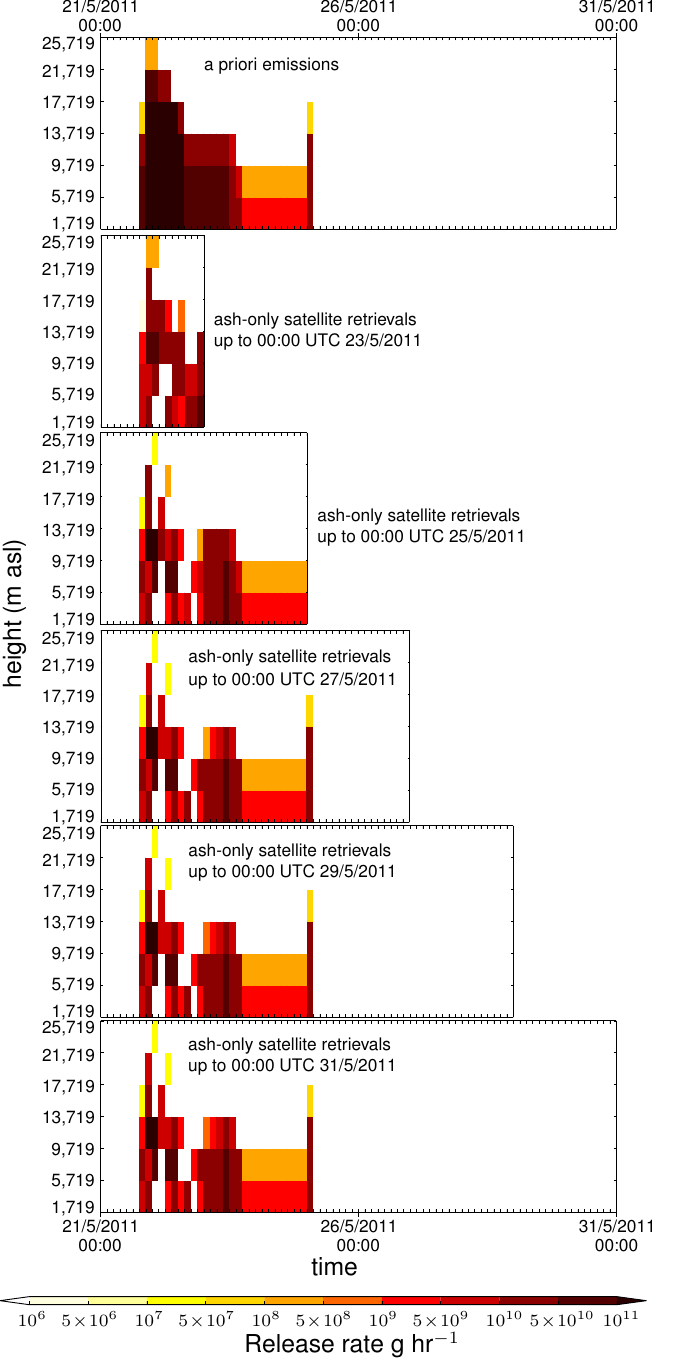
Figure 8. Emission profiles (g hr − 1 ) estimated by InTEM for the 2011 Grímsvötn eruption. The a priori emissions and the inversion emission profiles using the ash-only satellite retrievals available up to various cut-off times are shown. Each inversion emission profile uses two more days of satellite retrievals than the previous